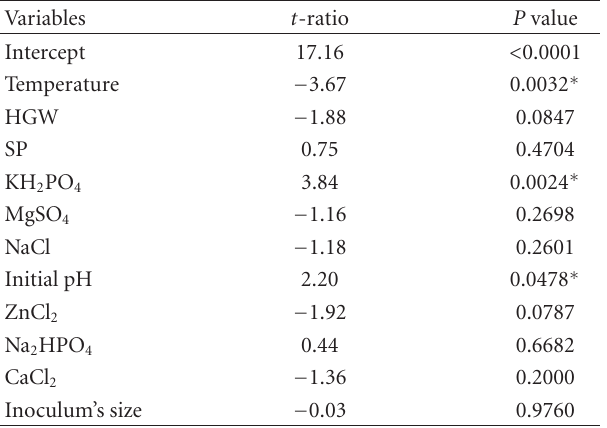
Table 4: Identification of significant variables for proteolytic enzymes production by A. niger I1 using Plackett-Burman